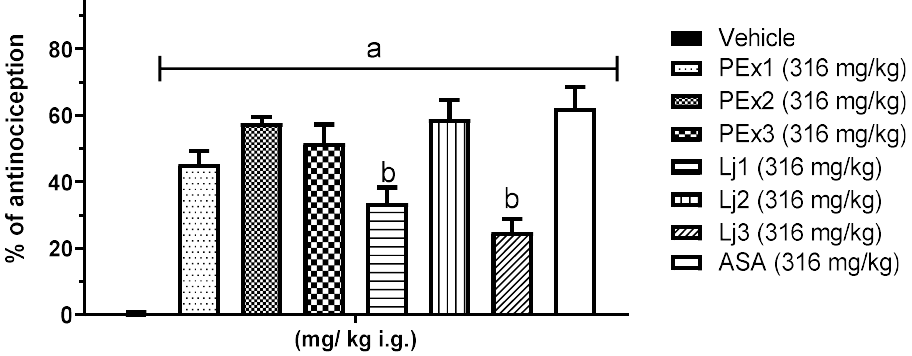
Figure 3. Percentage of global antinociception of the different treatment groups in the formalin test. a = Statistically significant difference versus Vehicle ( p < 0.05), b = Statistically significant difference versus ASA ( p < 0.05).